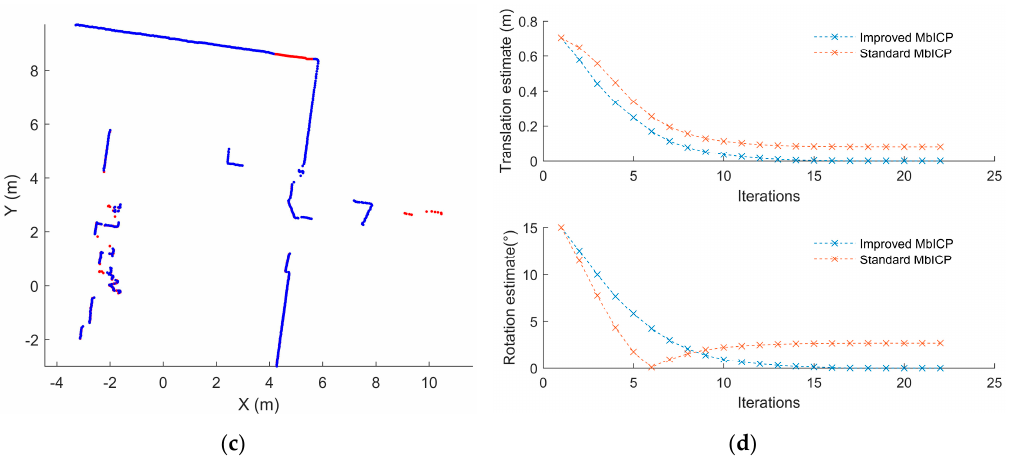
Figure 12. ( a ) Object scan (blue) and reference scan (red); ( b ) matching result from the standard MbICP algorithm (red dots-reference scan, blue dots-transformed object scan); ( c ) matching result from the improved MbICP algorithm (red dots-reference scan, blue dots-transformed object scan); ( d ) iteration process.